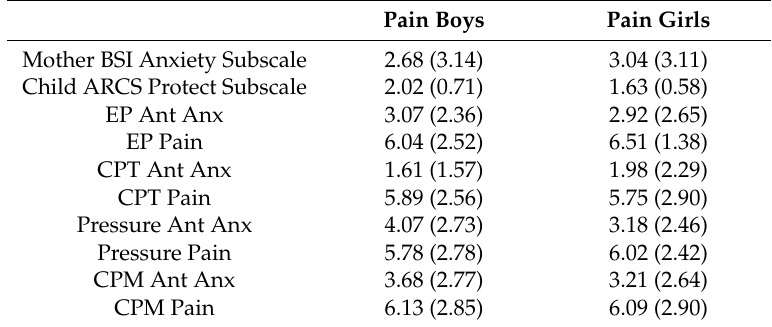
Table 2. Means (standard deviation, SD) of maternal psychosocial variables and child laboratory pain variables for boys and girls.